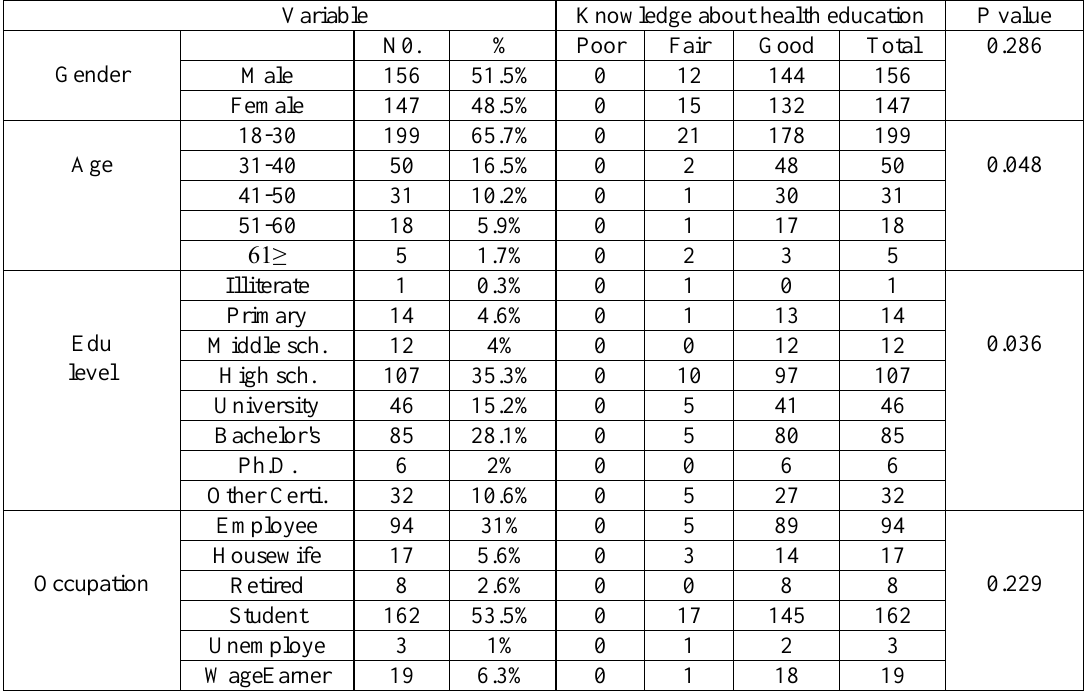
Table (1) : Association between